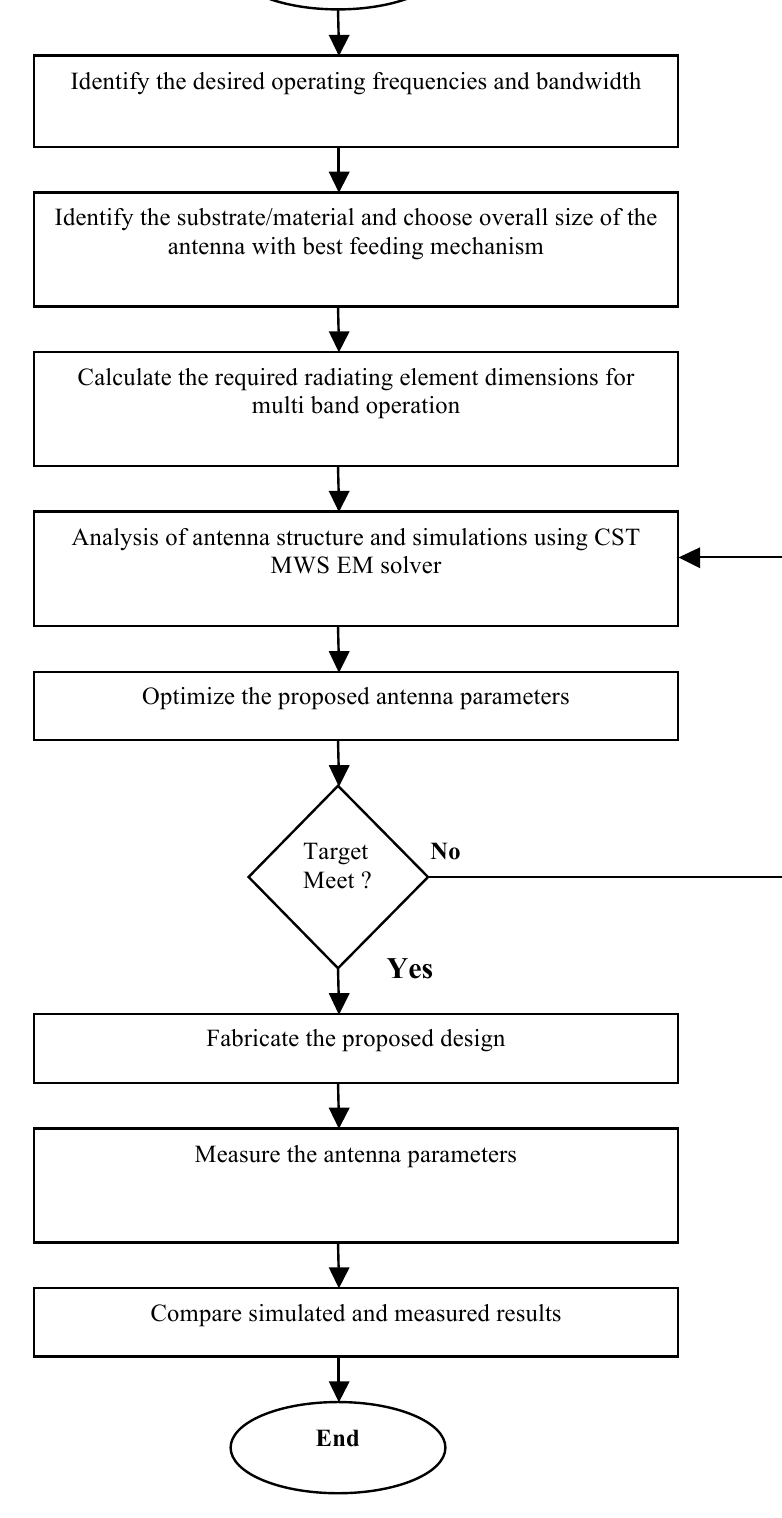
Figure 4: Design flow of meandered shaped ACS fed uniplanar wideband